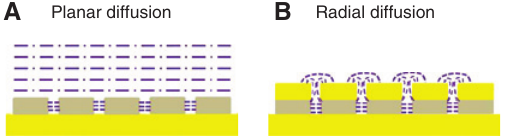
Figure 9: Schematic illustrations of diffusion mode for densely packed MEAs. (A) Planar diffusion over the entire array; (B) hemi- sphere diffusion due to effect of floating top metal film as bipolar